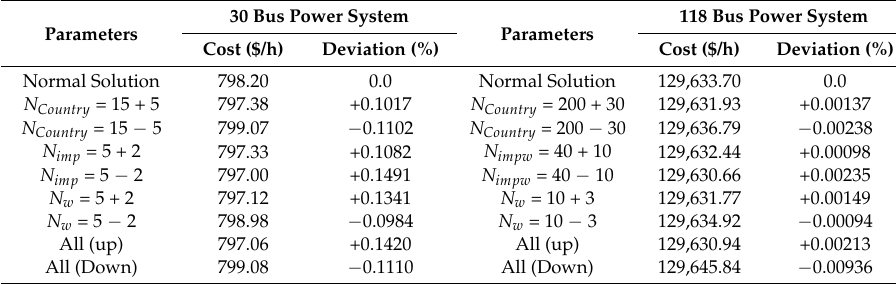
Table 18. Sensitivity analysis for IEEE 30 bus and 118 bus power systems.